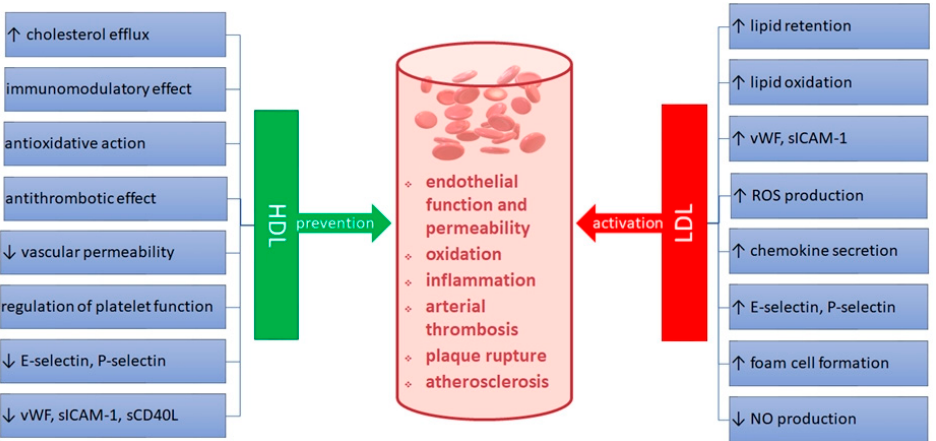
Figure 1. Possible role of high-density (HDL) and low-density (LDL) lipoproteins in the pathogen- esis of atherosclerosis and coronary artery disease (CAD). ROS—reactive oxygen species; sCD40L—soluble CD40 ligand; sICAM-1—intracellular adhesion molecule-1; vWF—von Willebrand factor. The level of HDL in the blood serum can be evaluated based on the level of the HDL cholesterol fraction (HDL-C) or on the concentration of the protein components (apo AI),